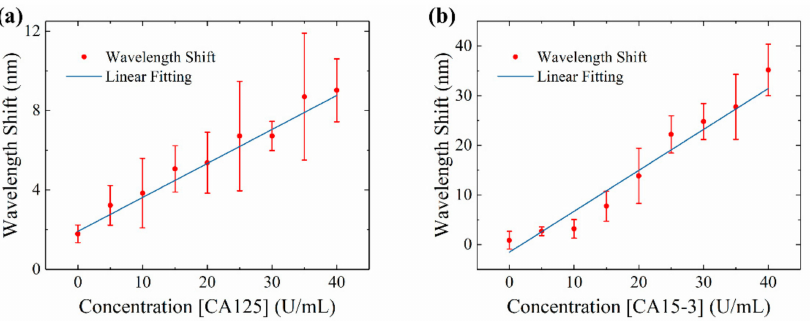
Figure 6. Reference curve of CA125 and CA15-3. ( a ) Reference curve of CA125 ranges from 0–40 U / mL; ( b ) Reference curve of CA15-3 ranges from 0–40 U /